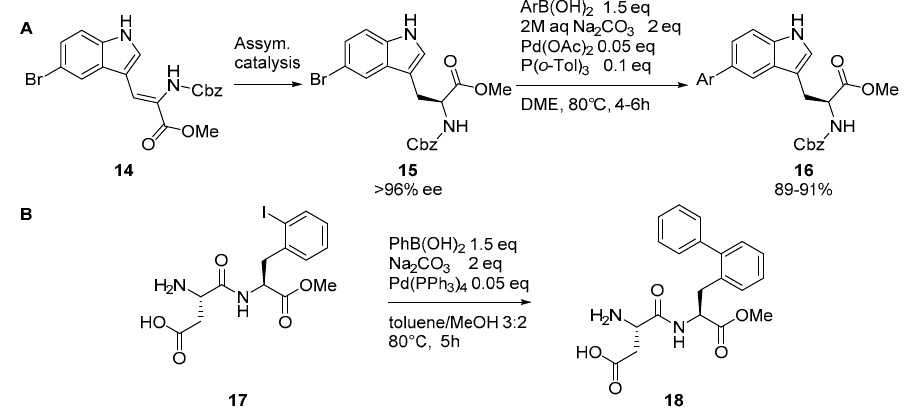
Figure 3. ( A ) Access to 5-aryltryptophans 16 via sequential asymmetric hydrogenation and Suzuki– Miyaura reaction. ( B ) Iodinated aspartame 17 transformed via